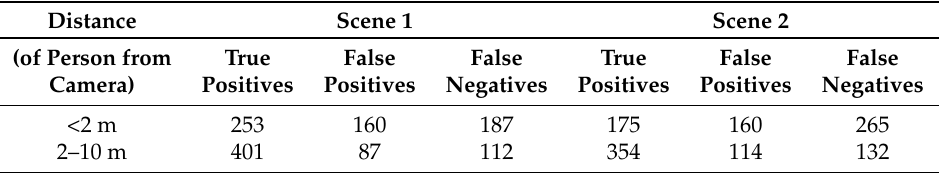
Table 2. Distance consideration for the validation of the work.